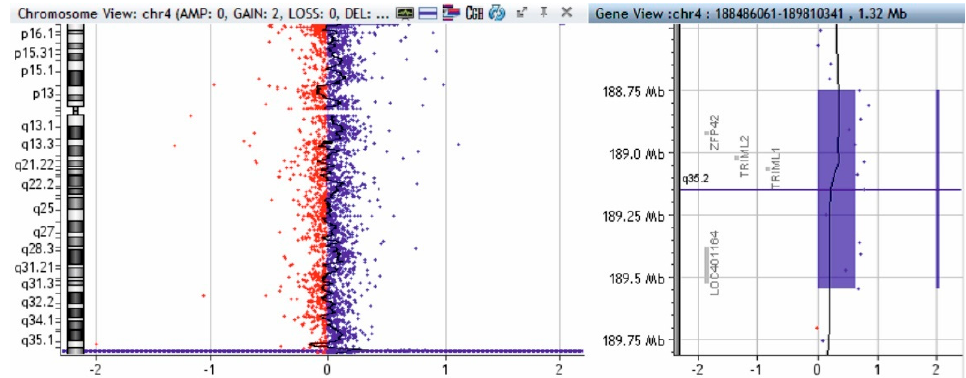
Figure 7. Array-CGH test of patient’s mother—triplication of 795 kb in the 4q35.2 region (shaded in blue). Red and blue dots represent the log2 ratio of fluorescence (Cy5/Cy3), calculated by analytical software; log2 ratio at 1 indicates a duplication of the DNA of the region (3 copies) in the test sample versus the control (in blue color) and a log2 ratio at -1 indicates a deletion of the DNA of that region in the test sample versus the control (red deviation).